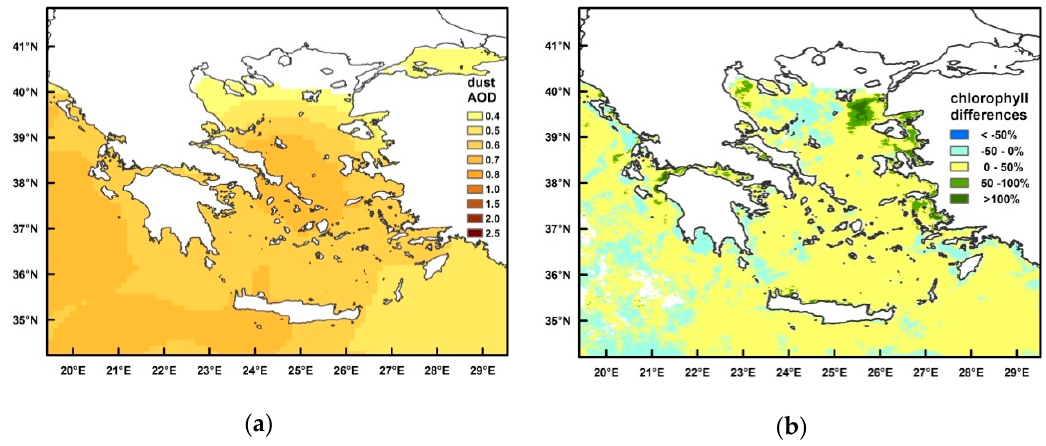
Figure 6. ( a ) Maximum dust AOD during the episode 21–23 September 2014; ( b ) Chl-a % differences between the weeks before (14–21 September 2014) and after (30 September–7 October 2014) the